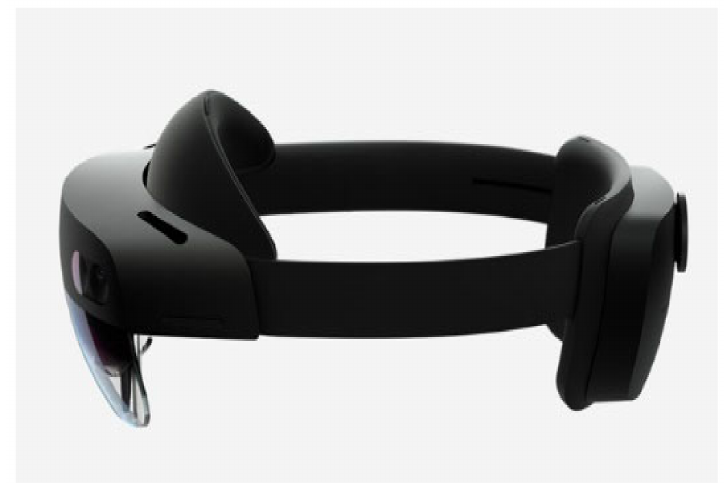
Figure 6. Microsoft ® HoloLens 2 AR